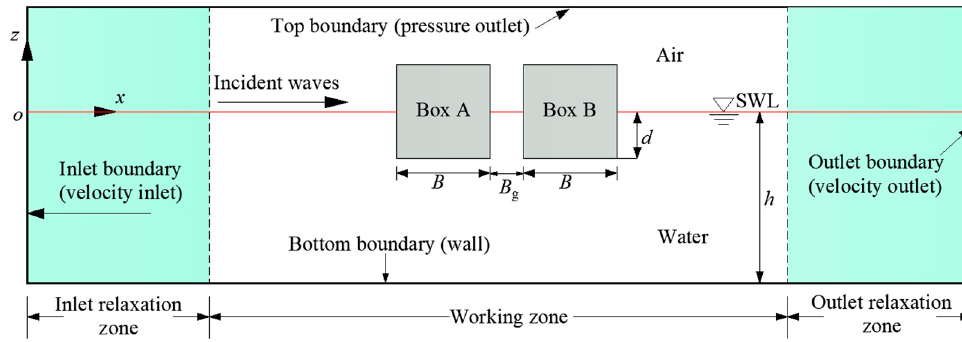
Figure 1. Sketch of the numerical wave tank.